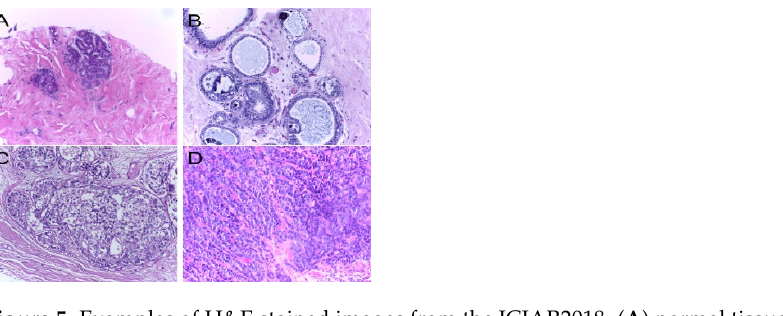
Figure 8. Example for Partitioning and resizing the IDC dataset. Figure 9. Example for Partitioning and resizing the BreCaHAD dataset. 2.2.2. Data Augmentation The proposed system employed several data augmentation techniques, such as rota- tion, shifting, brightness, shearing, zooming, and flipping, as shown below, to overcome the problem of unbalanced data and to increase the number of samples in the dataset. Data augmentation includes a set of techniques that improve the attributes and size of datasets (see Figure 10). Thus, DL models can perform better when using these technolo- gies. Table 2 shows some of the data augmentation parameters that are used in the pro- posed work. Table 2. Data augmentation parameters. Augmentation Parameter